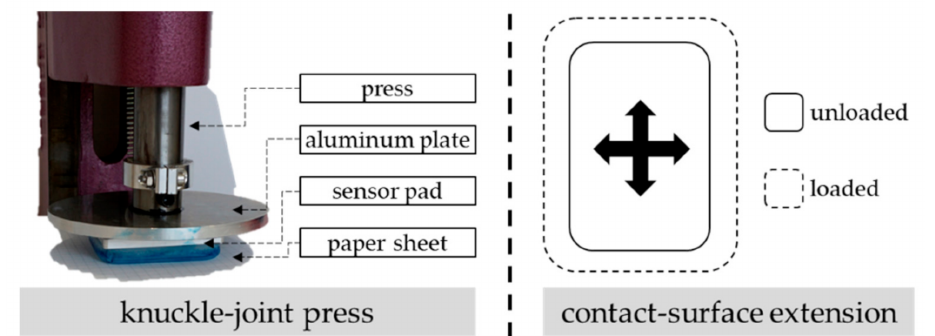
Figure 8. Knuckle-joint press with clamped sensor pad and inked silicon capsule on paper sheet ( left ). Schematic contact-surface extension of the sensor pad due to external load ( right ).